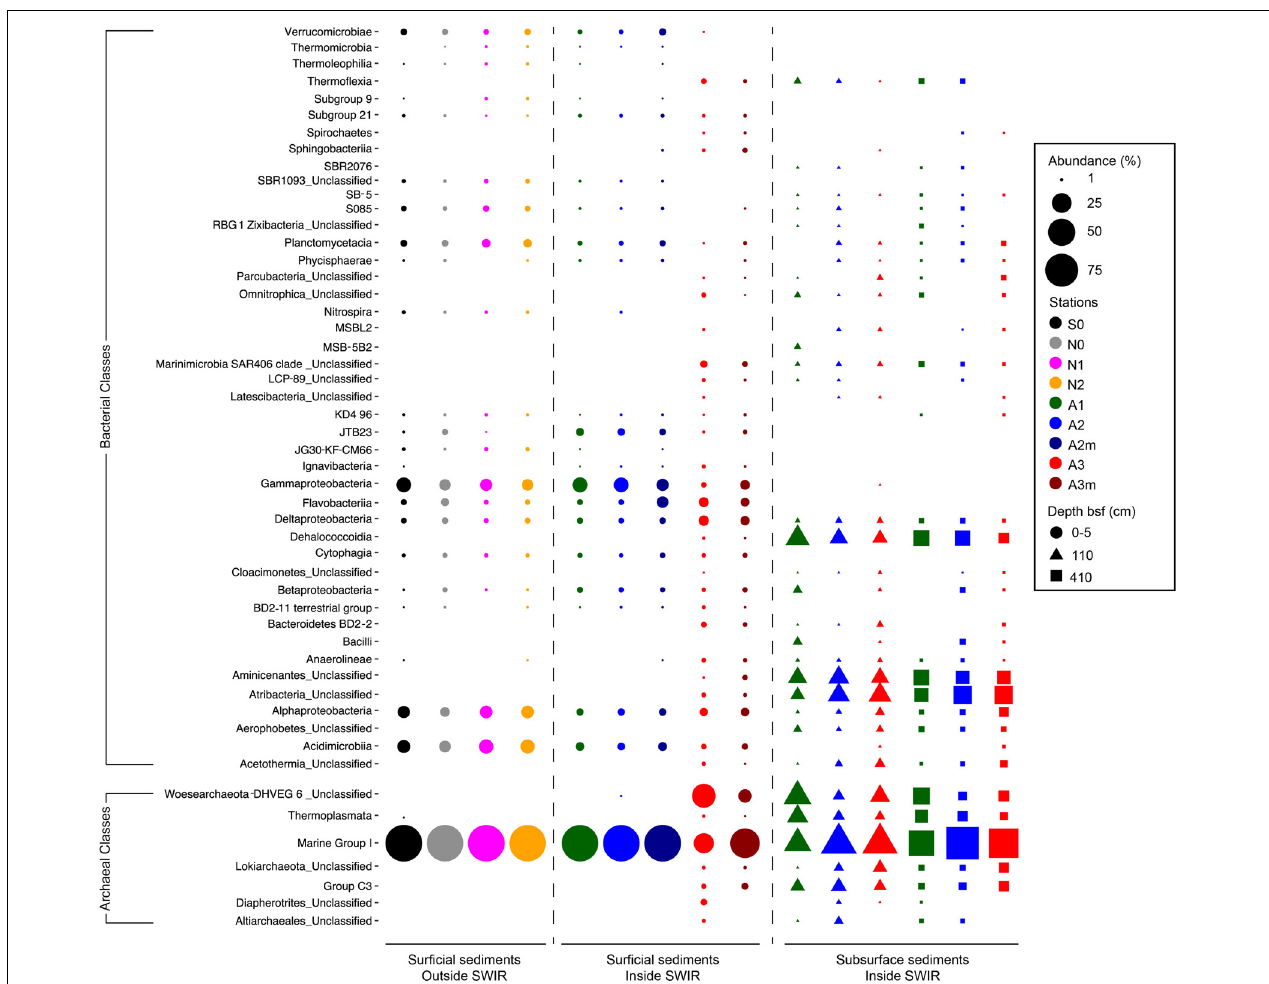
FIGURE 3 | Bacterial and archaeal community composition in surface and subsurface sediments. Relative sequence abundance of (A) bacterial and (B) archaeal 16S rRNA at Class level resolution. Dominant community is here showed (i.e., community composed by those taxa present in the dataset with a relative abundance higher than 1%). For those taxa unclassified at Class level the Phylum is